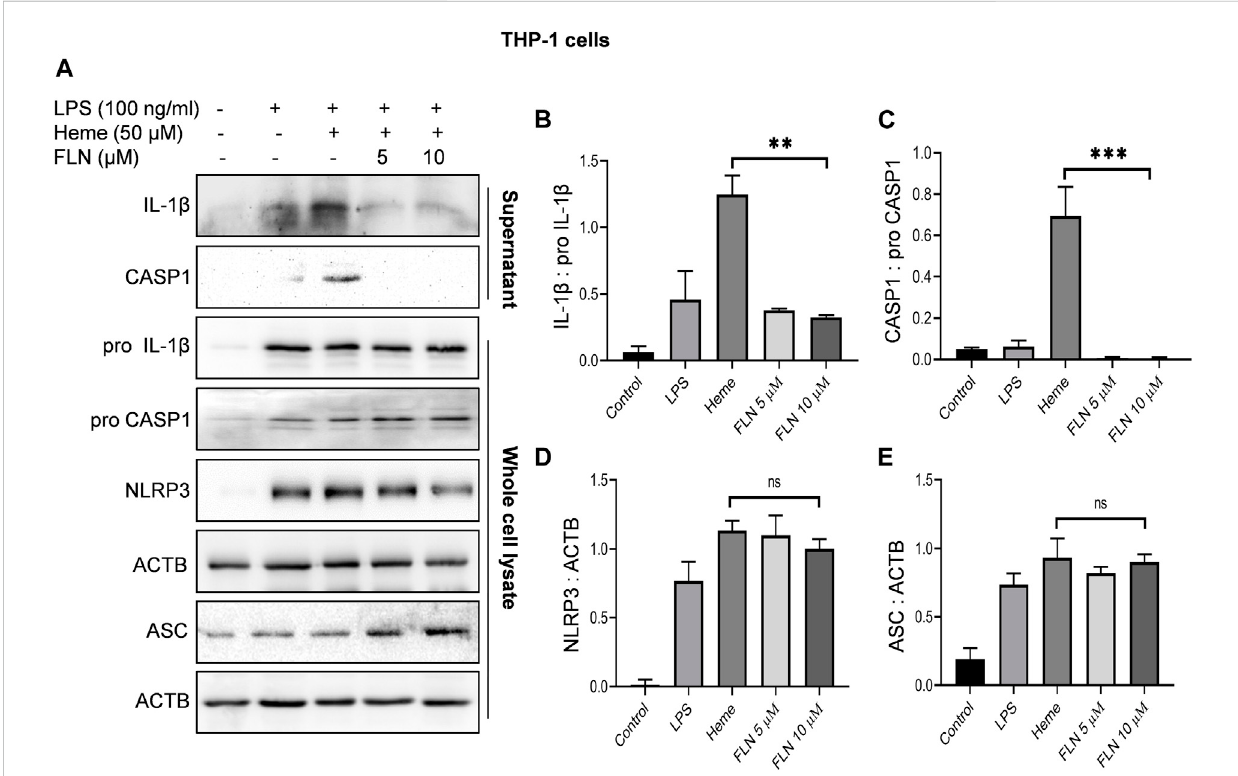
FIGURE 2 Effect ofFLNonNLRP3in fl ammasomecomplexproteins inhemeinducedTHP-1 cells. Cellsweretreatedas describedinFigure 1.Levelsofcleaved IL-1 β and cleaved CASP1 were checked by concentrating supernatant proteins and analyzing it through immunoblotting. Levels of pro CASP1, pro IL-1 β , NLRP3andASCweremeasuredinwholecelllysates. (A) ImmunoblotsofNLRP3in fl ammasomecomplexproteins.Densitometryanalysisofimmunoblots given in Figure 2A; (B) IL-1 β , (C) CASP1, (D) NLRP3, and (E) ASC protein in THP-1. Cleaved proteins were normalized with their pro-forms. For NLRP3 and ASC, ACTB was used as an internal control. Band densities were quanti fi ed using Image J software. The data presented here is the mean of three independent experiments ±SD. Statistical signi fi cance was calculated using one-way ANOVA and Bonferroni test as post hoc . p < 0.05 was considered signi fi cant. *** p < 0.001, ** p < 0.01, * p <